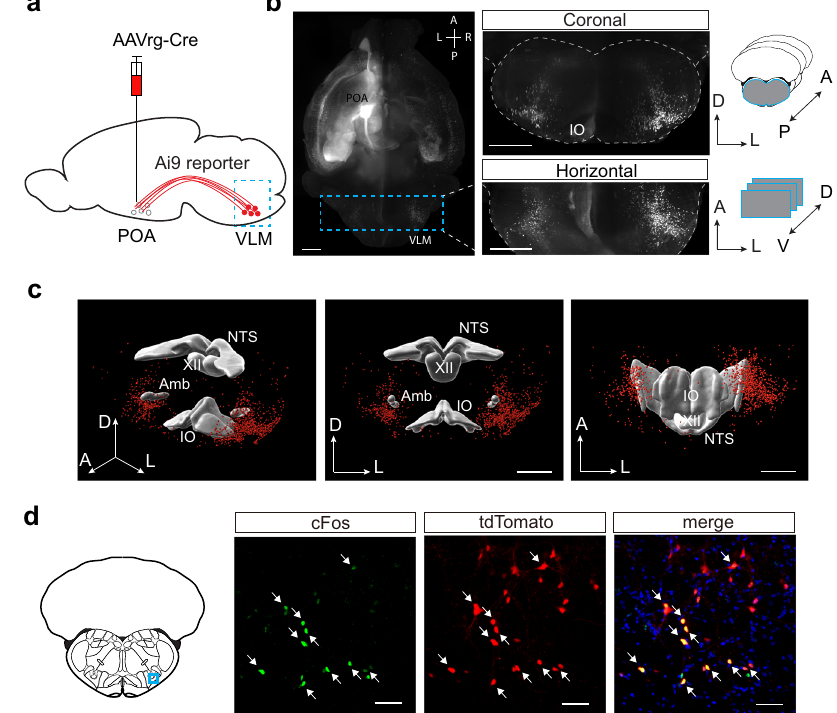
Fig.3|Medullaglutamatergicneuronsprojecttothepreopticarea.a Schematic illustrating retrograde labeling experiments in Ai9 reporter mice injected with AAVrg-hSyn.Cre.WPRE.hGHinthepreopticarea(POA).VLM,ventrolateralmedulla. b Left, maximum-intensity z stack of POA-projecting neurons in the whole mouse brain, cleared with CUBIC and imaged with light-sheet fl uorescent microscopy (a representative example from 3 mice). The dashed-line box illustrating the anterior and posterior boundaries used for reconstruction of coronal and horizontal views ontheright.Righttop,Maximum-intensityzstackofPOA-projectingneuronsinthe optically sliced coronal sections of the brainstem. Right bottom, Maximum- intensity z stack of POA-projecting neurons in the optically sliced horizontal